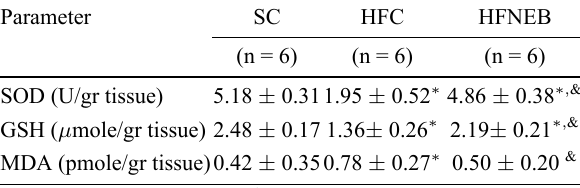
Table 4. Tissue oxidative status and antioxidant